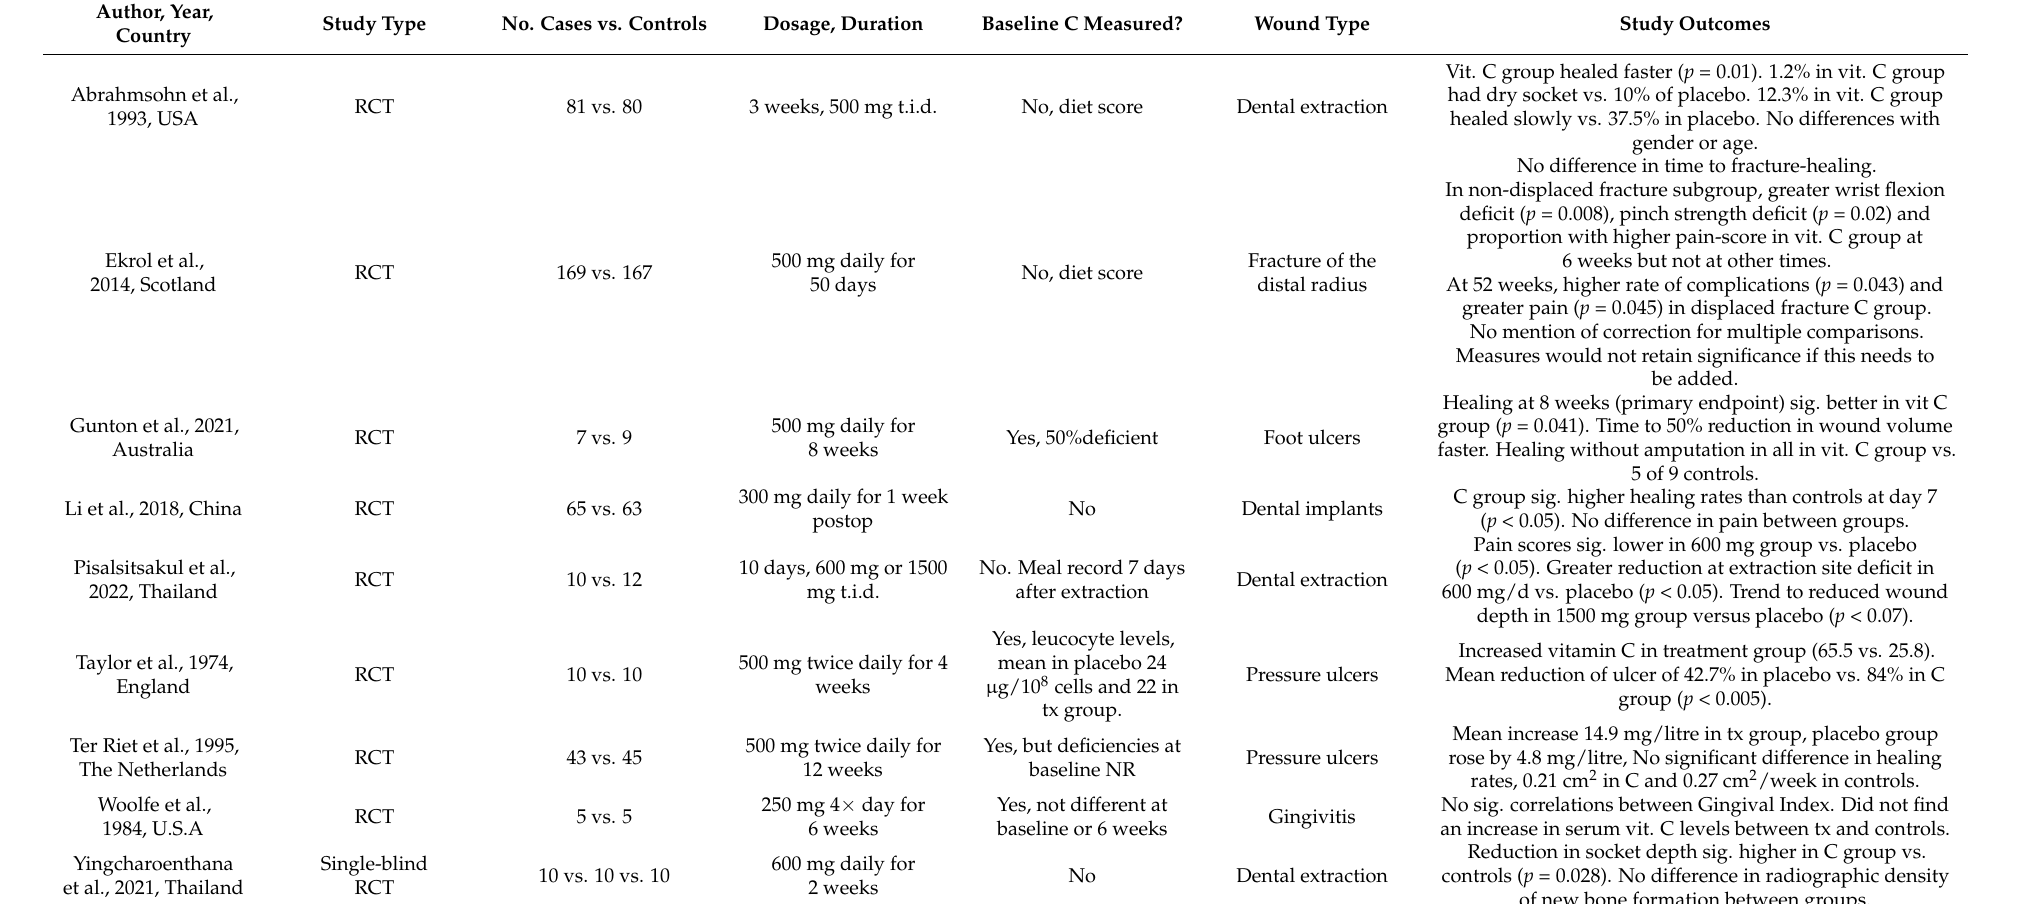
Table 2. Vitamin C